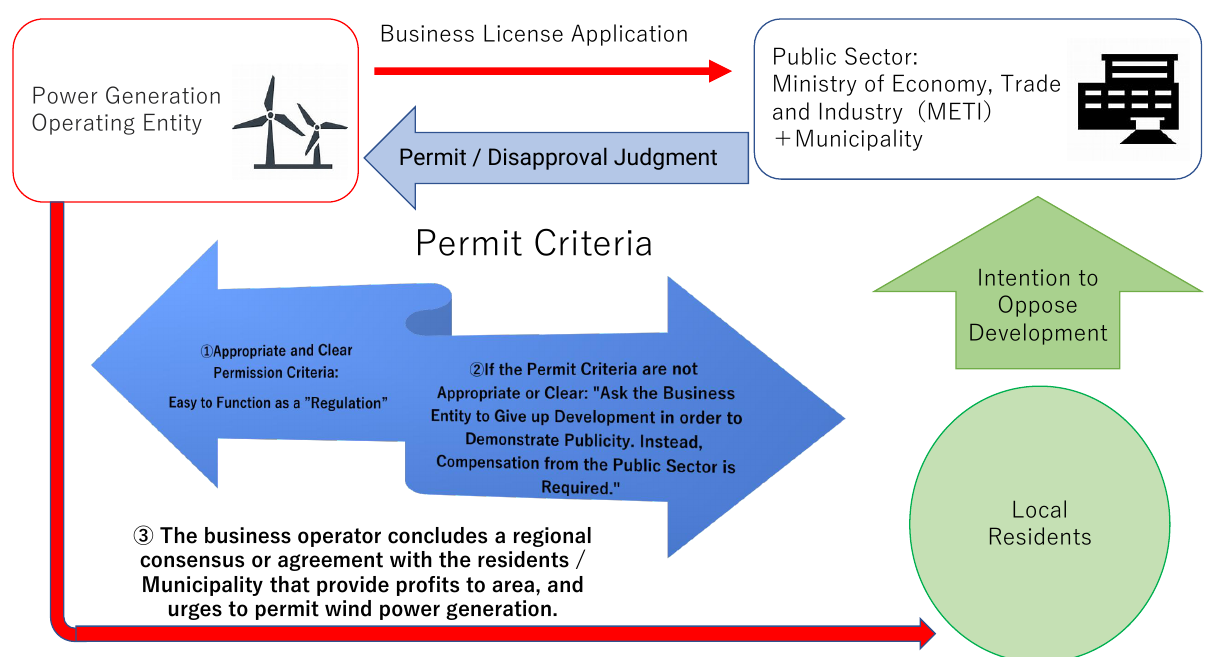
Figure 1. Parties involved in the issuance of business licenses for renewable energy projects in